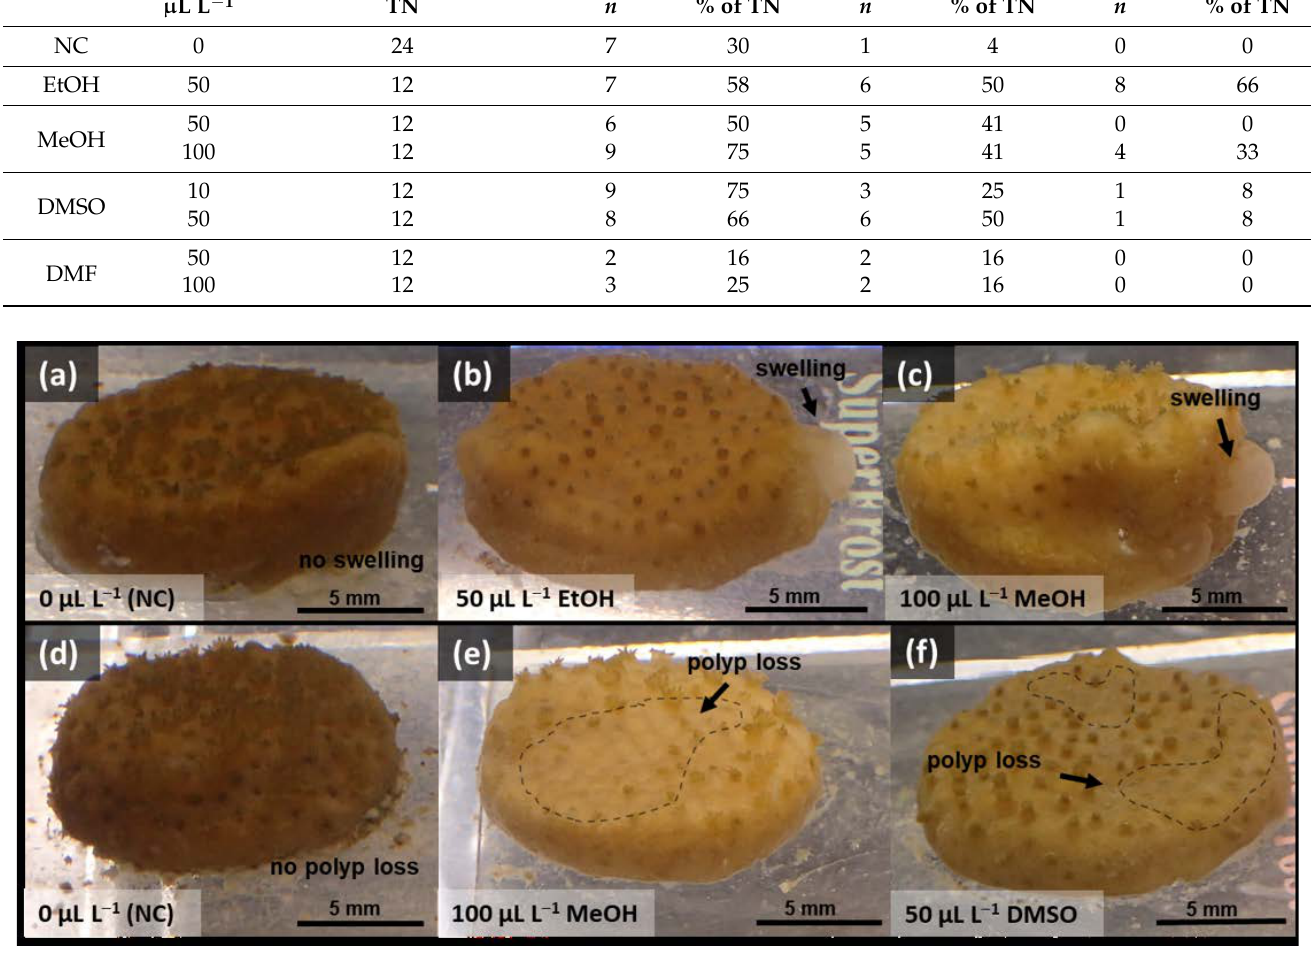
Figure 4. Examples of fragments of Montipora digitata with morphological abnormalities compared to the negative control ( a , d ), such as tissue swelling ( b , c ) and polyp losses ( e , f ) for different treatments after 16 days of